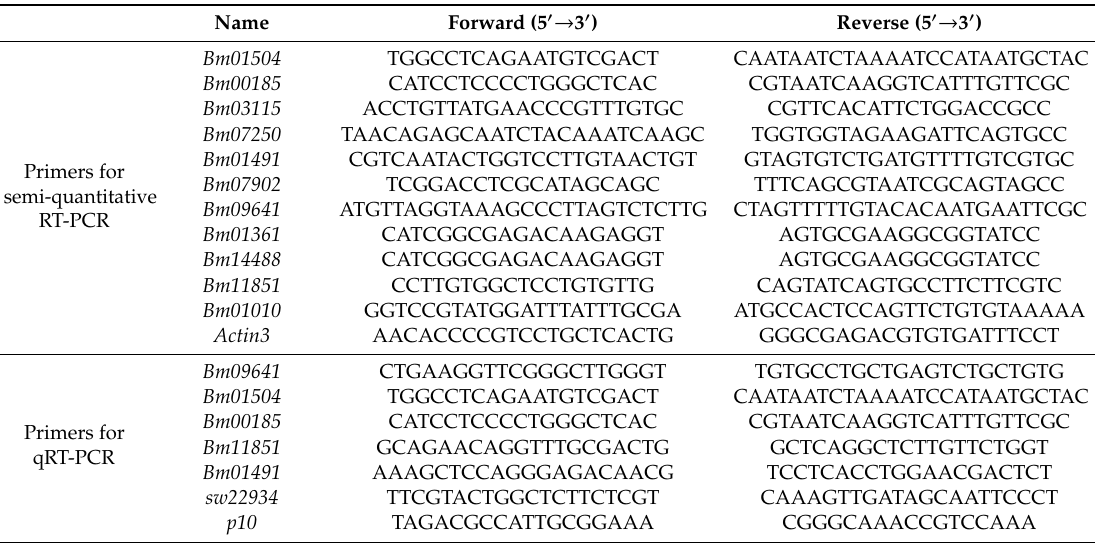
Table 2. Primers used for polymerase chain reaction